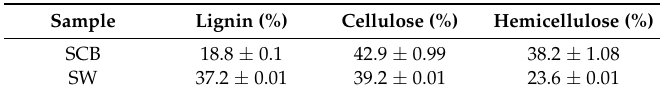
Table 1. Fractions of principal constituents of SCB and SW.